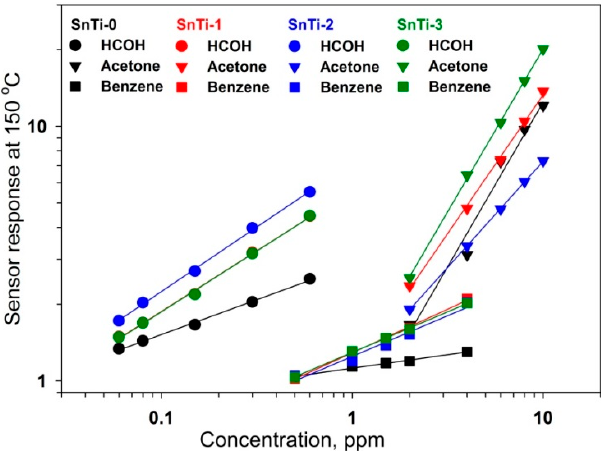
Figure 13. ( a ) Calibration curves for the HCHO detection using TiO 2 @SnO 2 nanocomposites at T = 150 °C under stepwise change of the HCHO concentration in dark conditions (left) and under UV periodic illumination (right). ( b ) Comparison of the values of the sensor response of SnTi-2 nanocomposite (triangles) with the literature data [8–11,20–23,28,87–117] (squares), Ref. [7] (diamonds) and Ref. [86] (circles). The color of the symbol corresponds to the measurement temperature. For correct comparison all the data were recalculated as S = ( R air / R gas - 1)*100%.